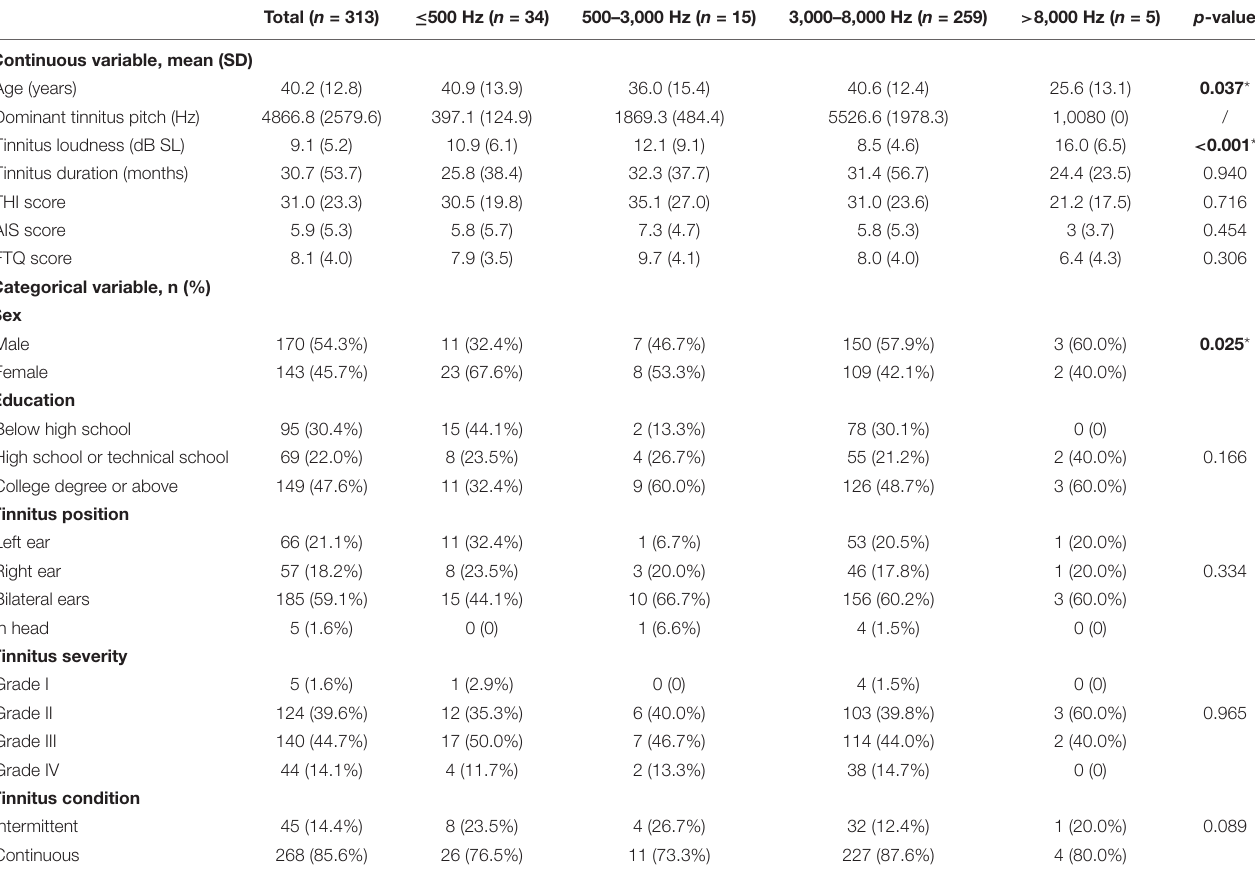
TABLE 1 | Demographic characteristics of patients with tinnitus and clinically normal